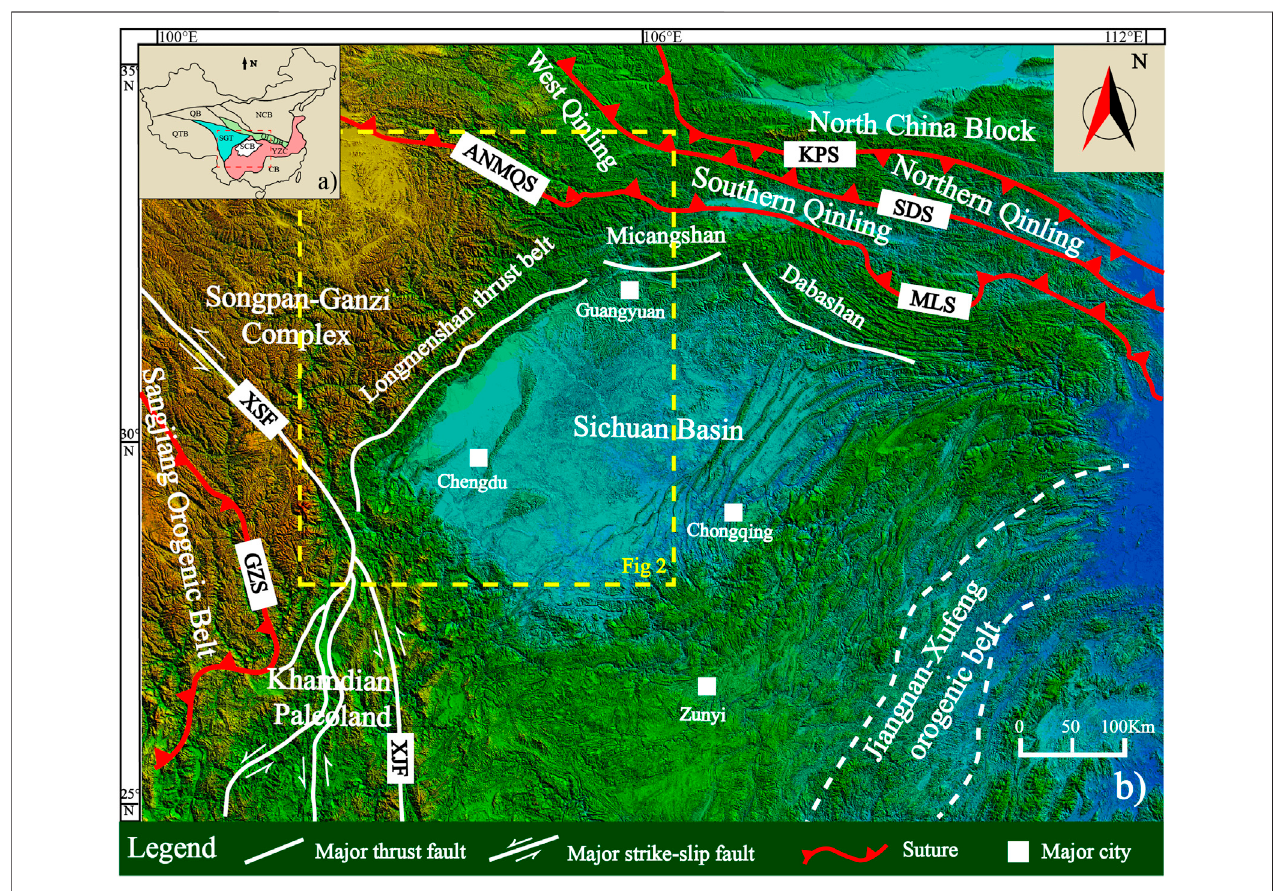
FIGURE 1 | Geological sketch map showing the tectonic of the South China Block (A) and Upper Yangtze area (B) (modi fi ed from M. Faure et al., 2017); ANMQ, Animaqin suture; MLS, Mianlue suture; SDS, Shangdan suture; KPS, Kuanping suture;XSF, Xianshuihe fault; XJF, Xiaojiang fault; GZS, Ganzi-Litang suture.